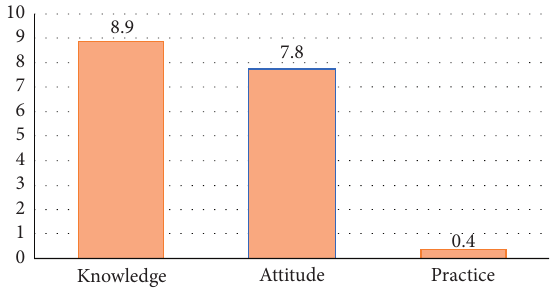
Figure 1: The mean of nurses’ knowledge, attitude, and practice regarding organ